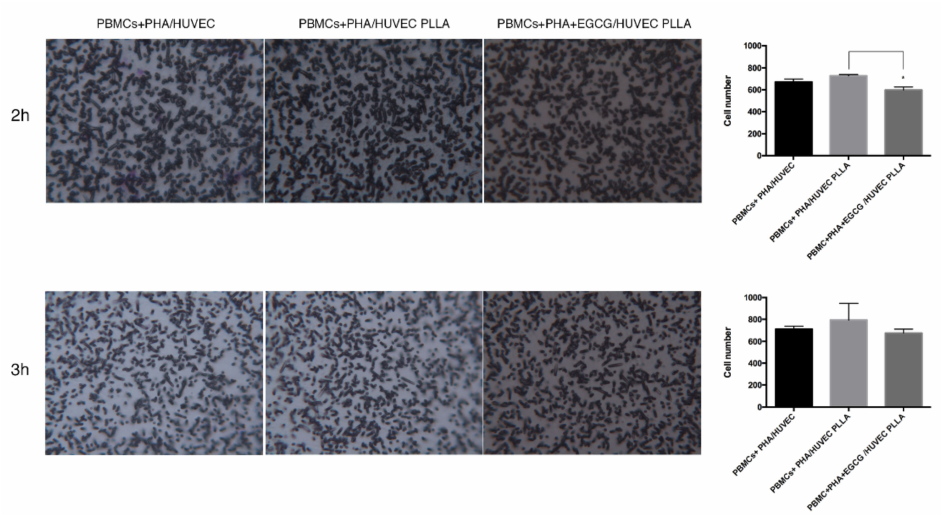
Figure 6. EGCG attenuates PBMC migration toward PLLA electrospun mat in a transwell co-culture system. HUVEC were cultured in presence of PLLA in the lower chamber of the transwell co-culture system for 48 h. PBMCs were seeded in the upper chamber, in RPMI medium enriched with PHA, ± EGCG (25 µ M). After 2 and 3 h, the membrane was processed for CV stain and PBMC visualization under light microscope (25 × magnification). Pictures and PBMC quantification are representative of three independent experiments. PBMC count was performed by using the cell counter plugin of ImageJ software. Data are expressed as mean ± SD, and statistical analysis was performed by unpaired Student’s t -test; *, p < 0.05. EGCG: epigallo-catechin-3-gallate; HUVEC: human umbilical vein endothelial cells; PBMCs: peripheral blood mononuclear cells; PHA, phytohemagglutinin; PLLA: poly-L-lactic